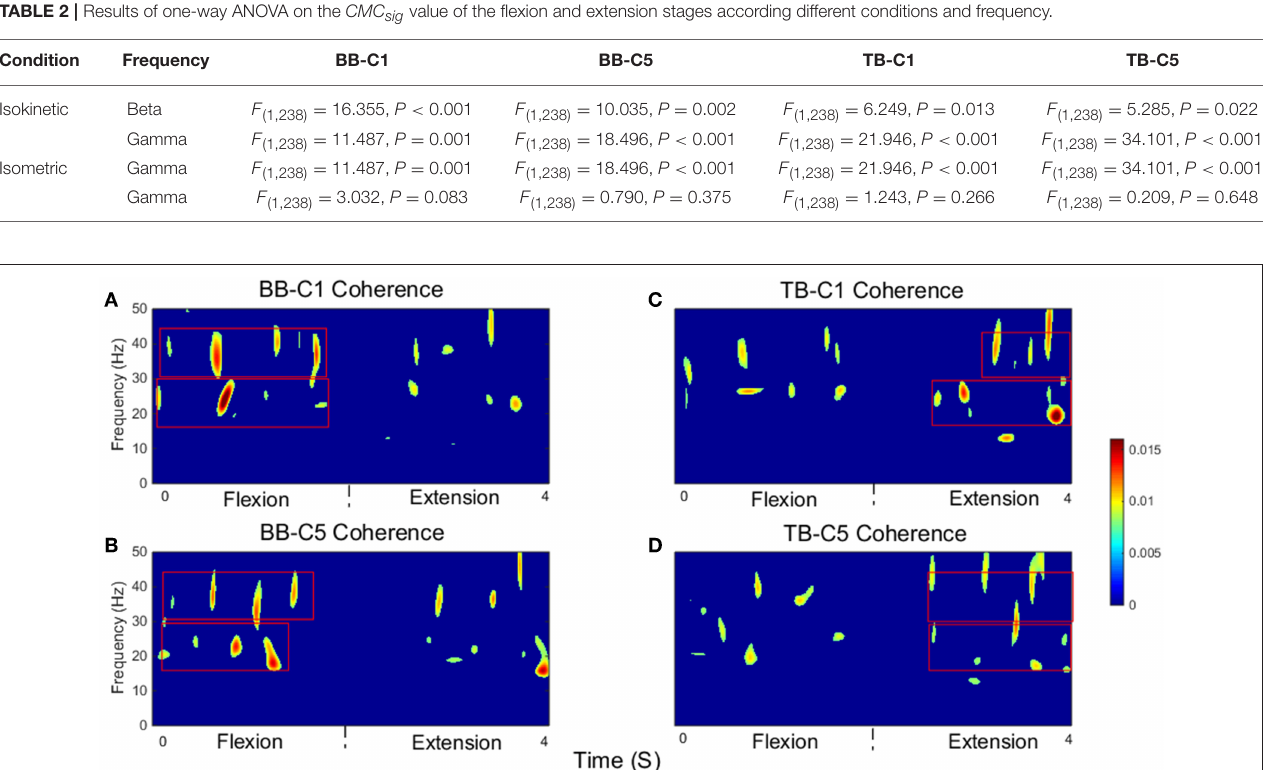
both muscles under C5 electrodes [ F (1,36)